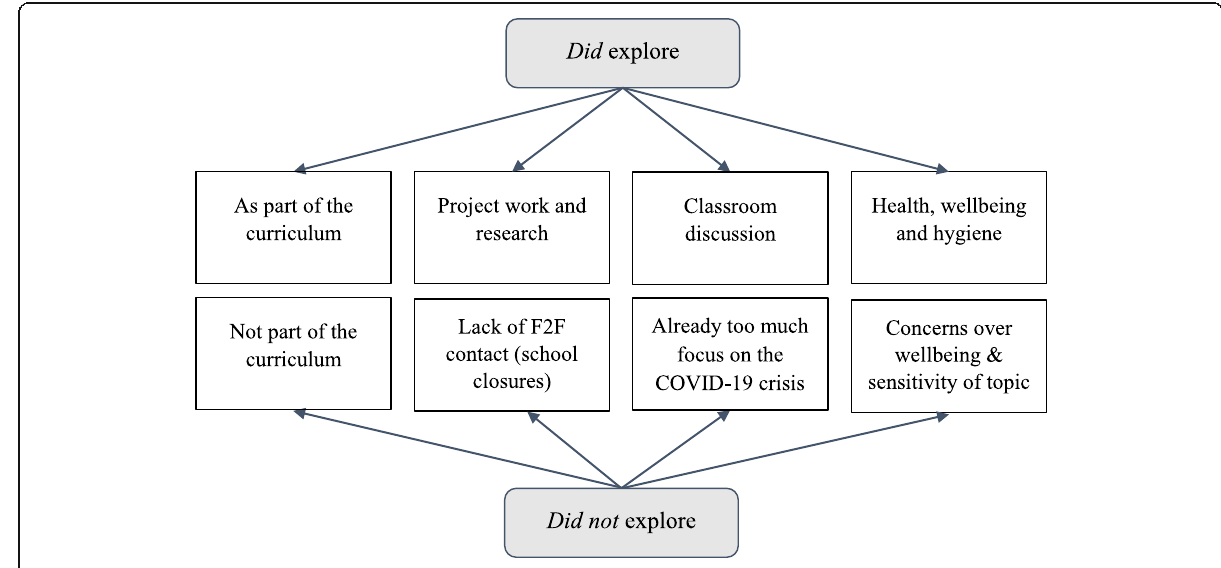
Fig. 1 Sub-themes for why teachers did and did not explore the COVID-19